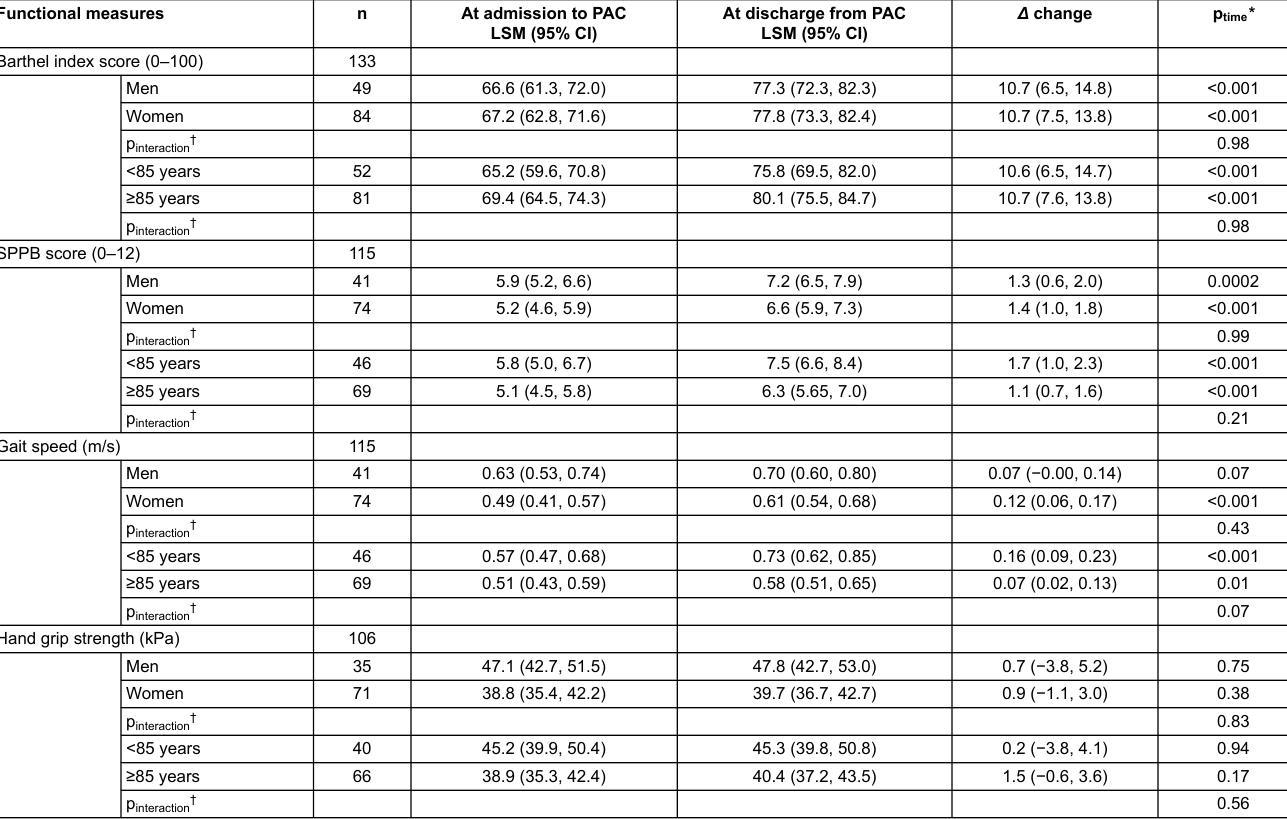
Table S2: Changes in functional measures in men vs women, and participants <85 vs ≥85 years undergoing post-acute care. Functional